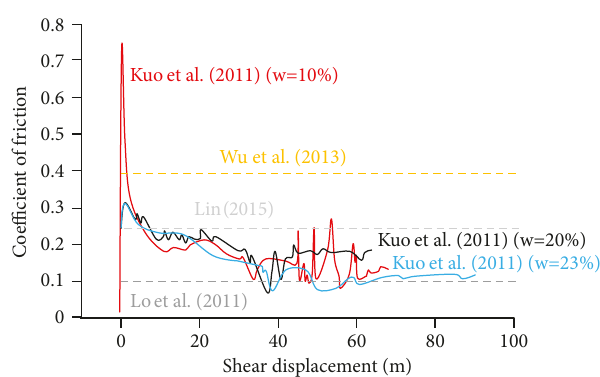
Figure 1: Di ff erent friction model for the initiation of the Hsien-du- shan